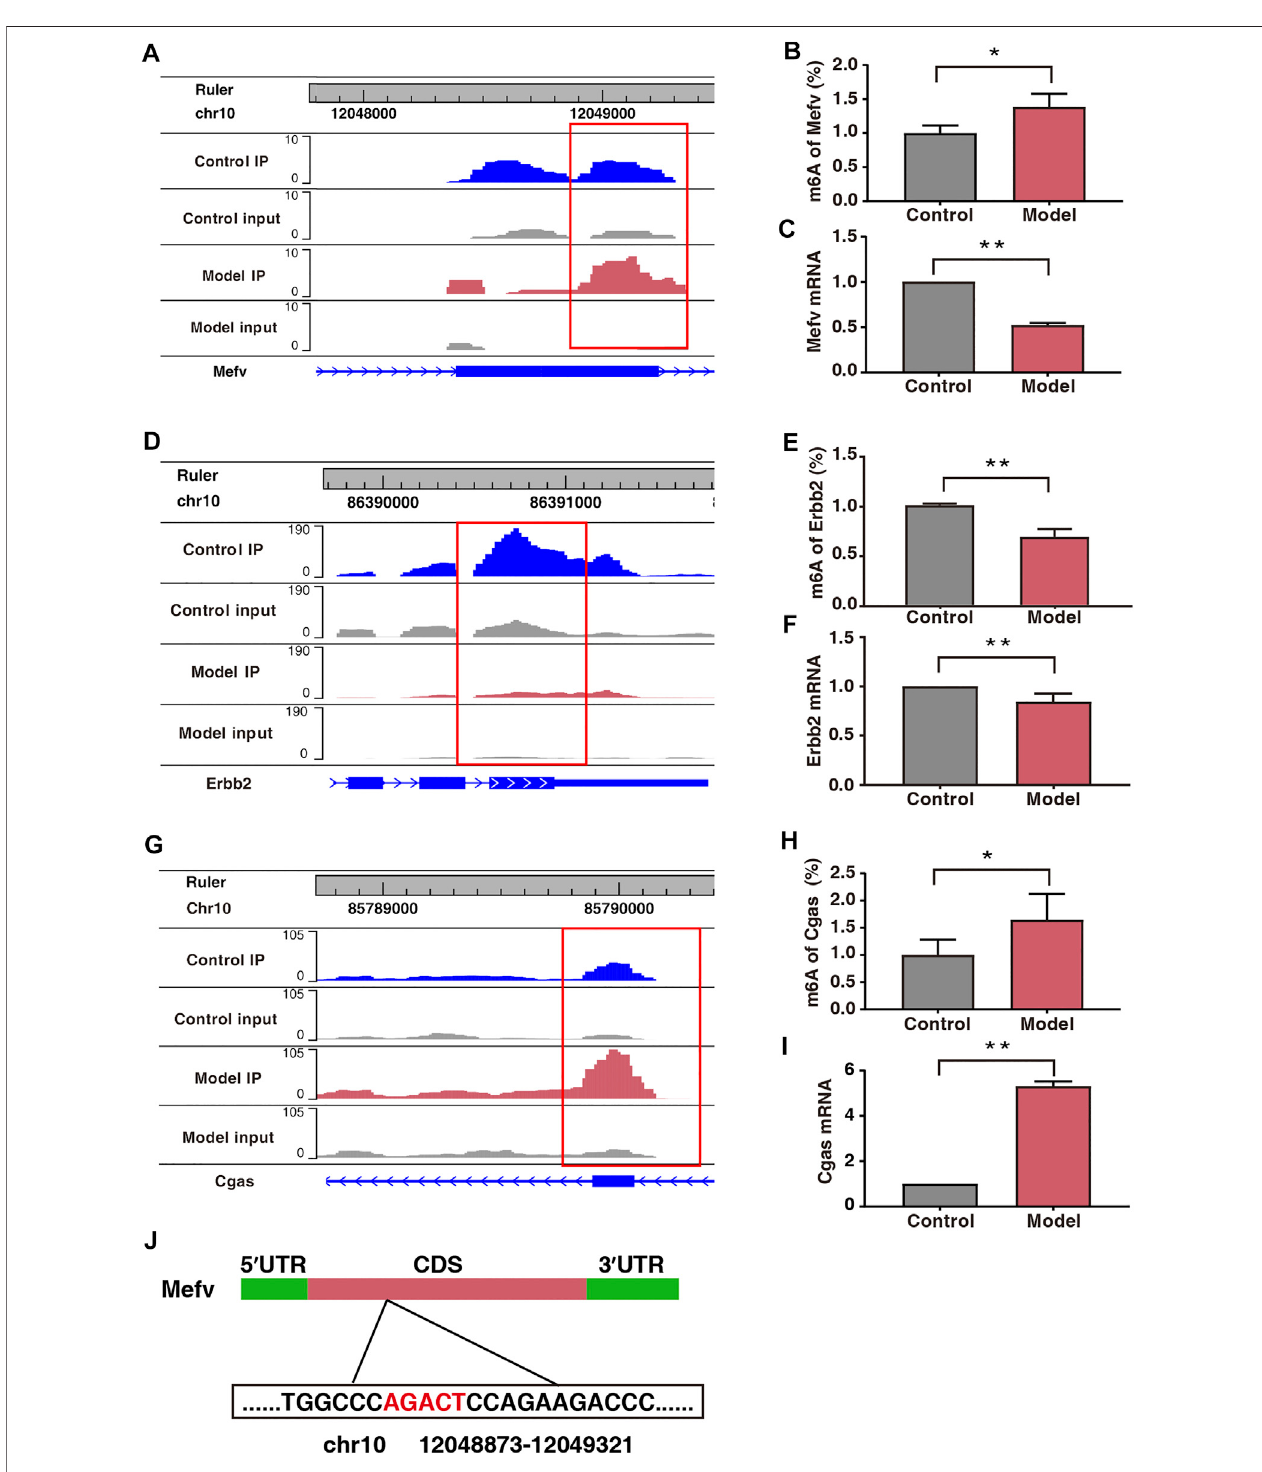
FIGURE 7 | Expression of Mefv , Erbb2 , and Cgas was regulated by m6A modi fi cation. (A) Data visualization analysis of Mefv mRNA m6A modi fi cation in the two groups. (B) m6A modi fi cation levels of Mefv at a particular site ( n * = 6, ** p < 0.05). (C) mRNA levels of Mefv in the two groups ( n * = 6, ** p < 0.01). (D) Data visualization analysisof Erbb2 mRNA m6A modi fi cation inthe twogroups. (E) m6Amodi fi cation levels of Erbb2 at aparticular site ( n *= 6, ** p < 0.01). (F) mRNA levels of Erbb2 in the twogroups( n *=6,** p < 0.01). (G) Datavisualizationanalysisof Cgas mRNAm6Amodi fi cationinthetwogroups. (H) m6Amodi fi cationlevelsof Cgas ataparticular site ( n * = 6, ** p < 0.05). (I) mRNA levels of Cgas in the two groups ( n * = 6, ** p < 0.01). (J) Schematic representation of the location of m6A modi fi cation site in Mefv .